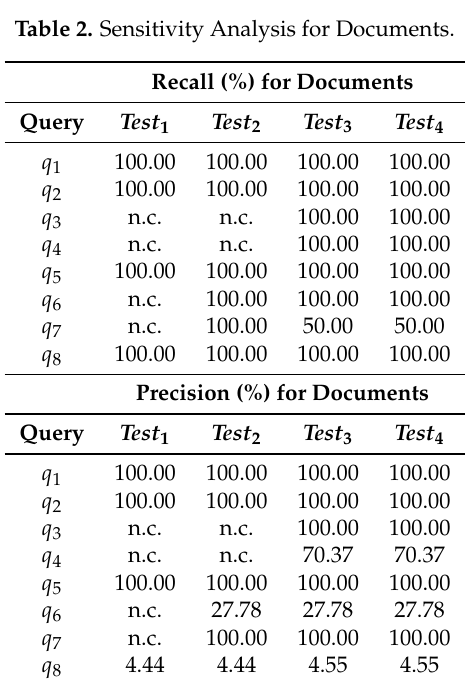
Table 2. Sensitivity Analysis for